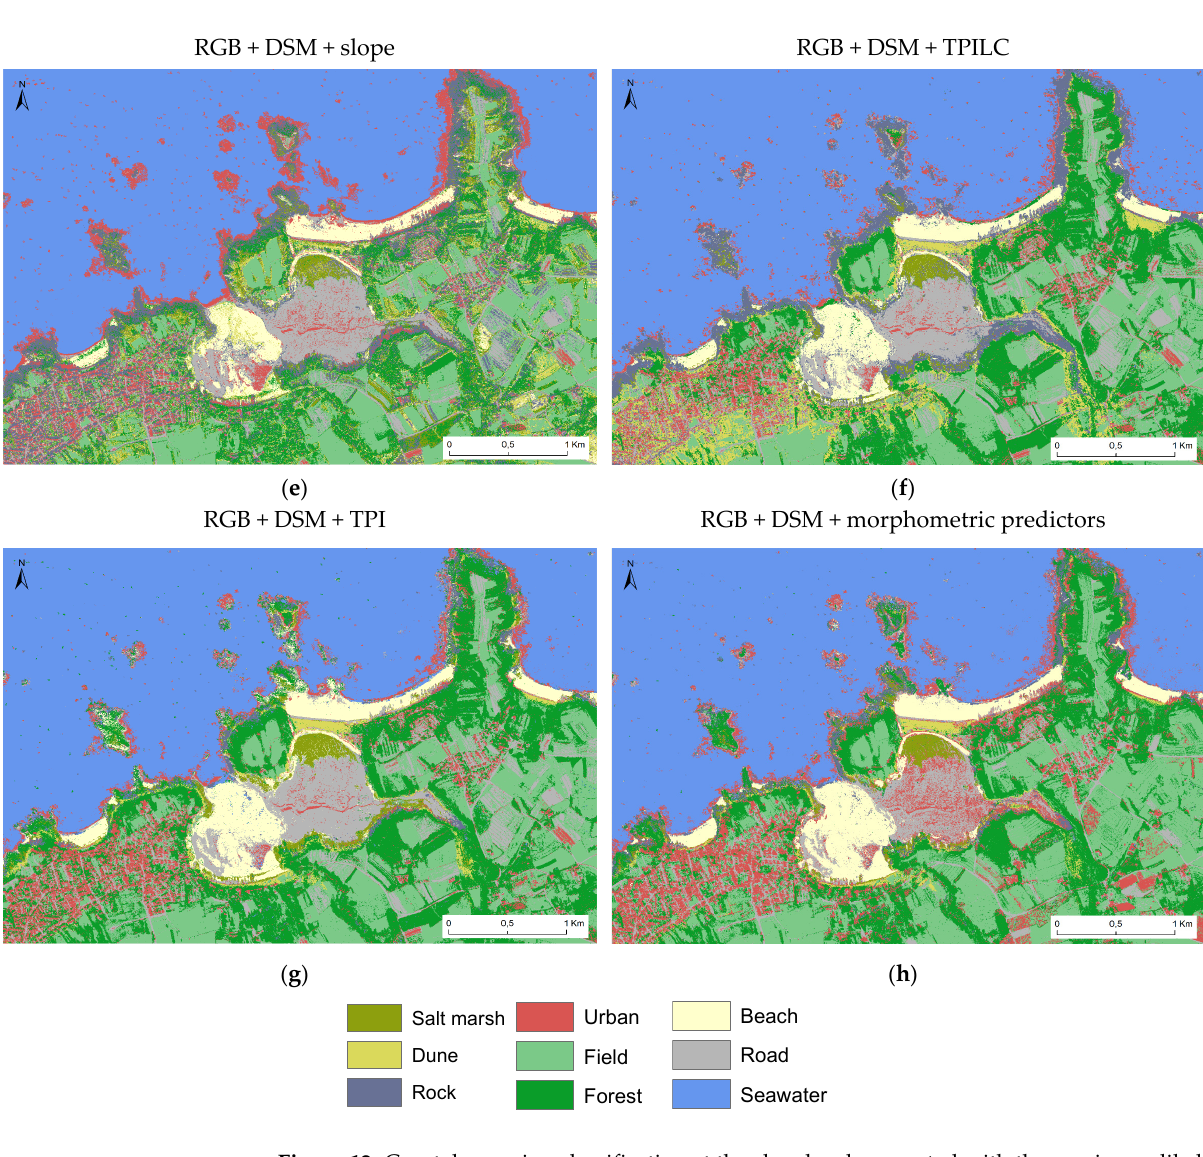
Figure 12. Coastal mapping classification at the class level computed with the maximum likelihood classifier: Basis RGB ( a ); RGB + NIR ( b ); RGB + DSM ( c ); RGB + DSM + slope ( d ); RGB + DSM + aspect ( e ); RGB + DSM + TPI ( f ); RGB + DSM + TPILC ( g ); RGB + DSM + morphometric predictors ( h ).